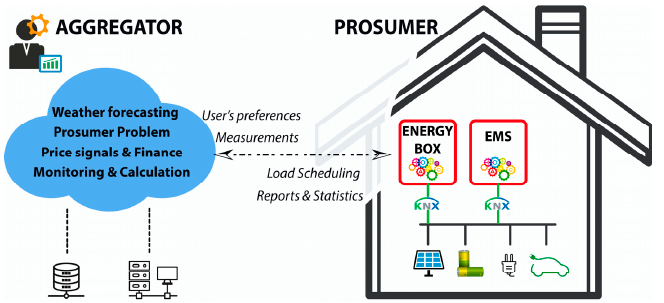
Figure 1. An energy box in a cloud-based architecture for autonomous demand response. HEMS: home energy management system.